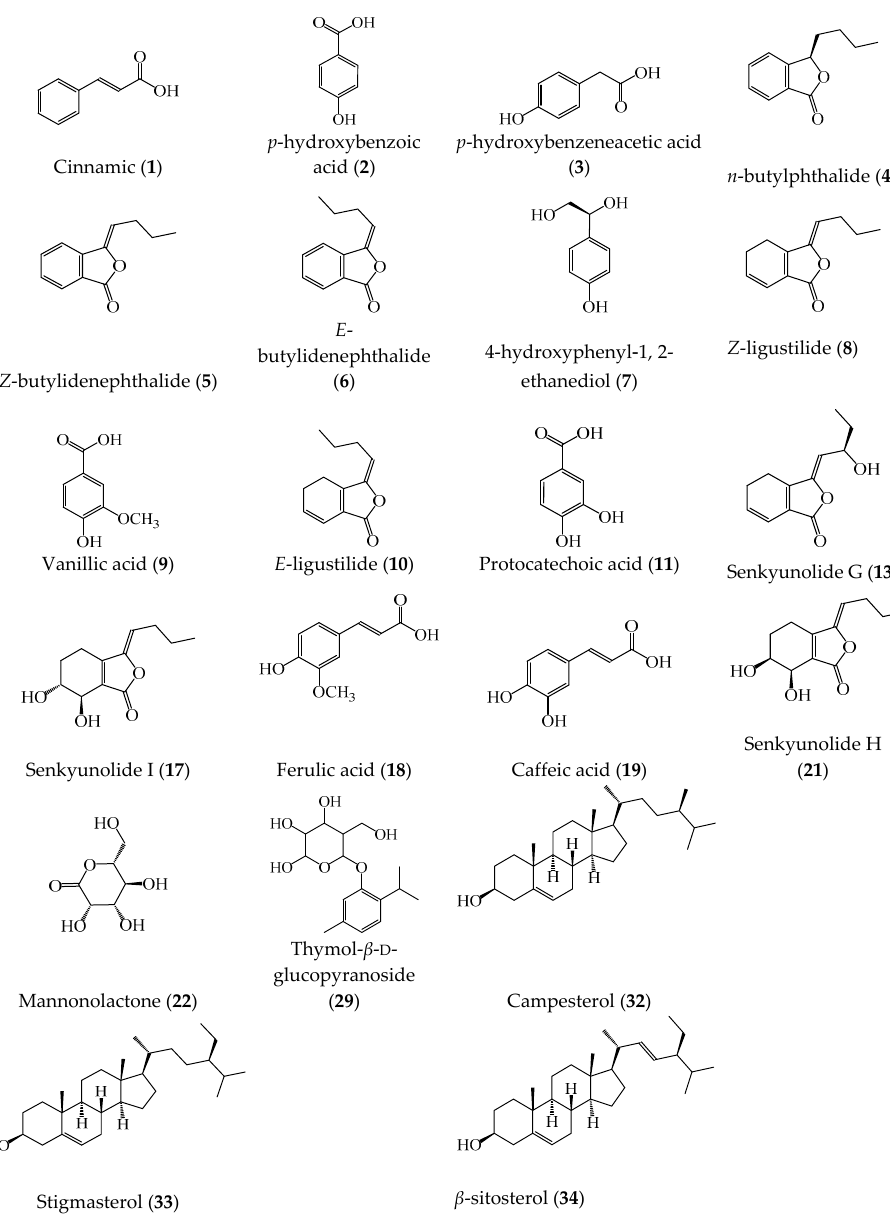
Figure 3. Chemical structures of some compounds identified in extracts of Angelica sinensis stem and root by GC–MS. The numbers in brackets correspond to the peak numbers of GC chromatograms in Figure